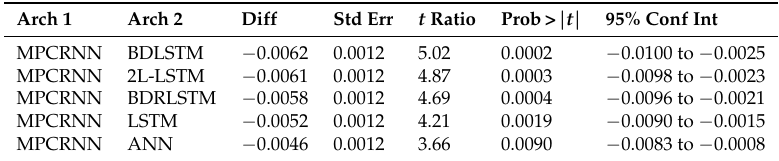
Table 8. Post-hoc Tukey HSD results between architectures, for the cross-participant variance of classification accuracy ANOVA. Only significant results are shown ( α = 0.05).